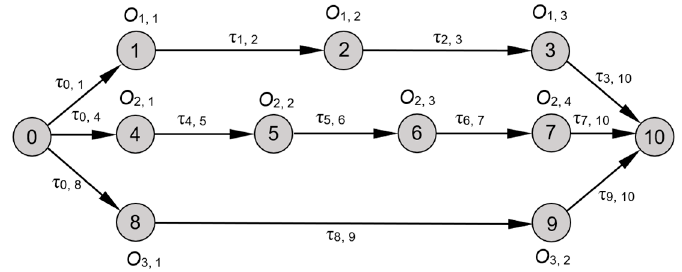
Figure 2. Disjunctive graph of Ant Colony Optimization (ACO) algorithm.